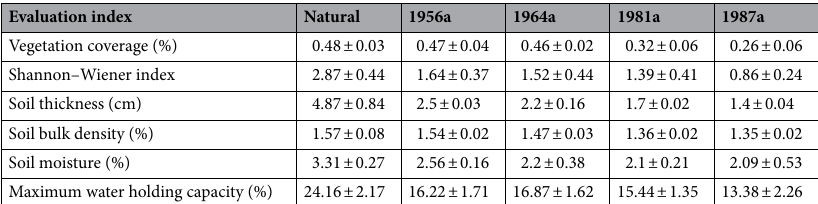
Table 1. The mean and standard deviation of the evaluation